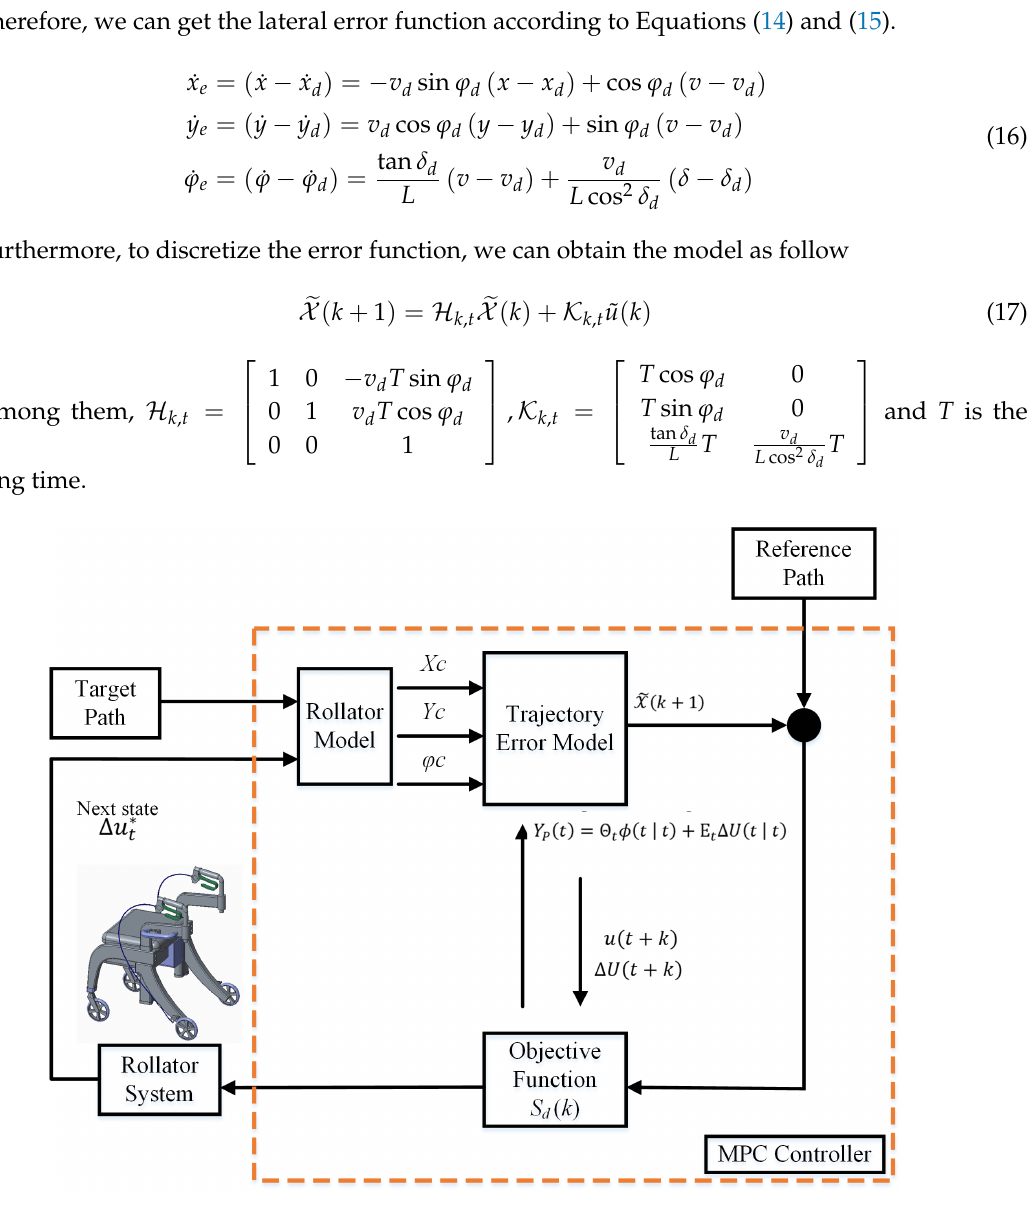
Figure 7. MPC controller